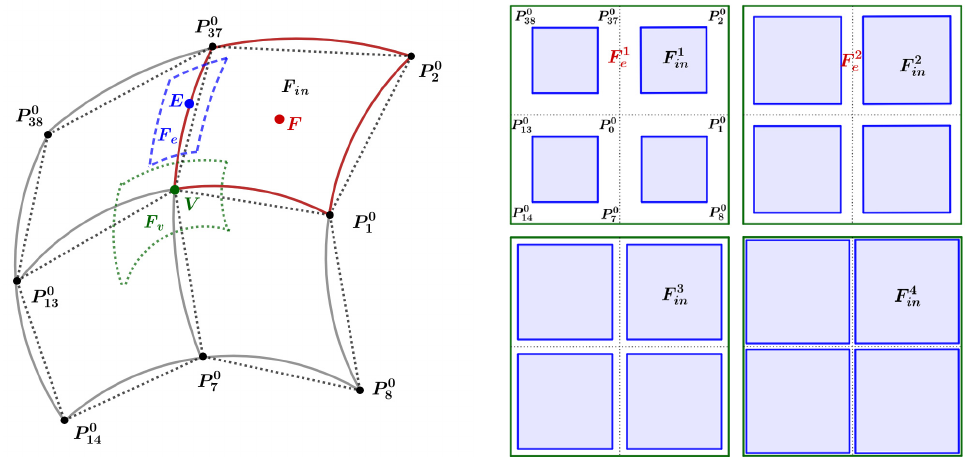
Figure 11. Three kinds of patches of the limit surface. Left: three types of limit surface. Right: the schematic diagram of the tensor product regions after 1, 2, 3 and 4 subdivisions.